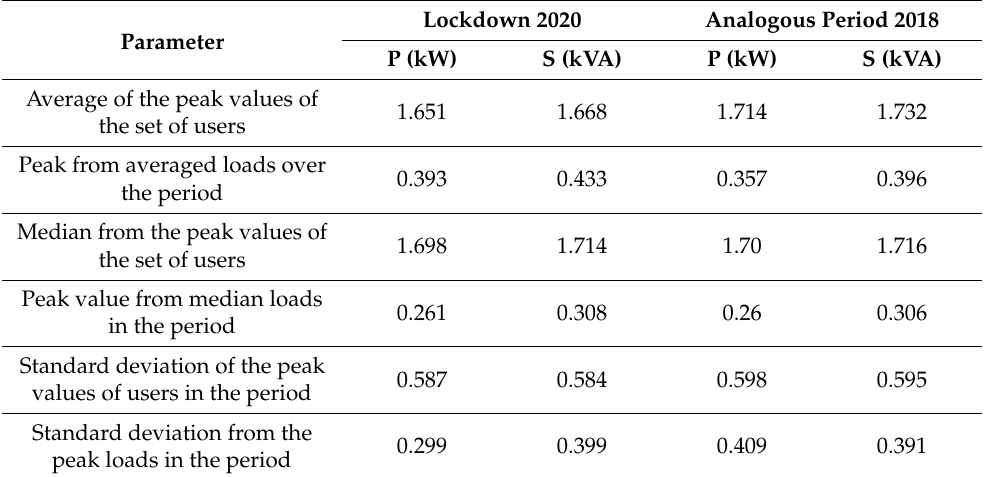
Table 1. Average values of the peak loads (active power P, apparent power S) of the analysed group of residential